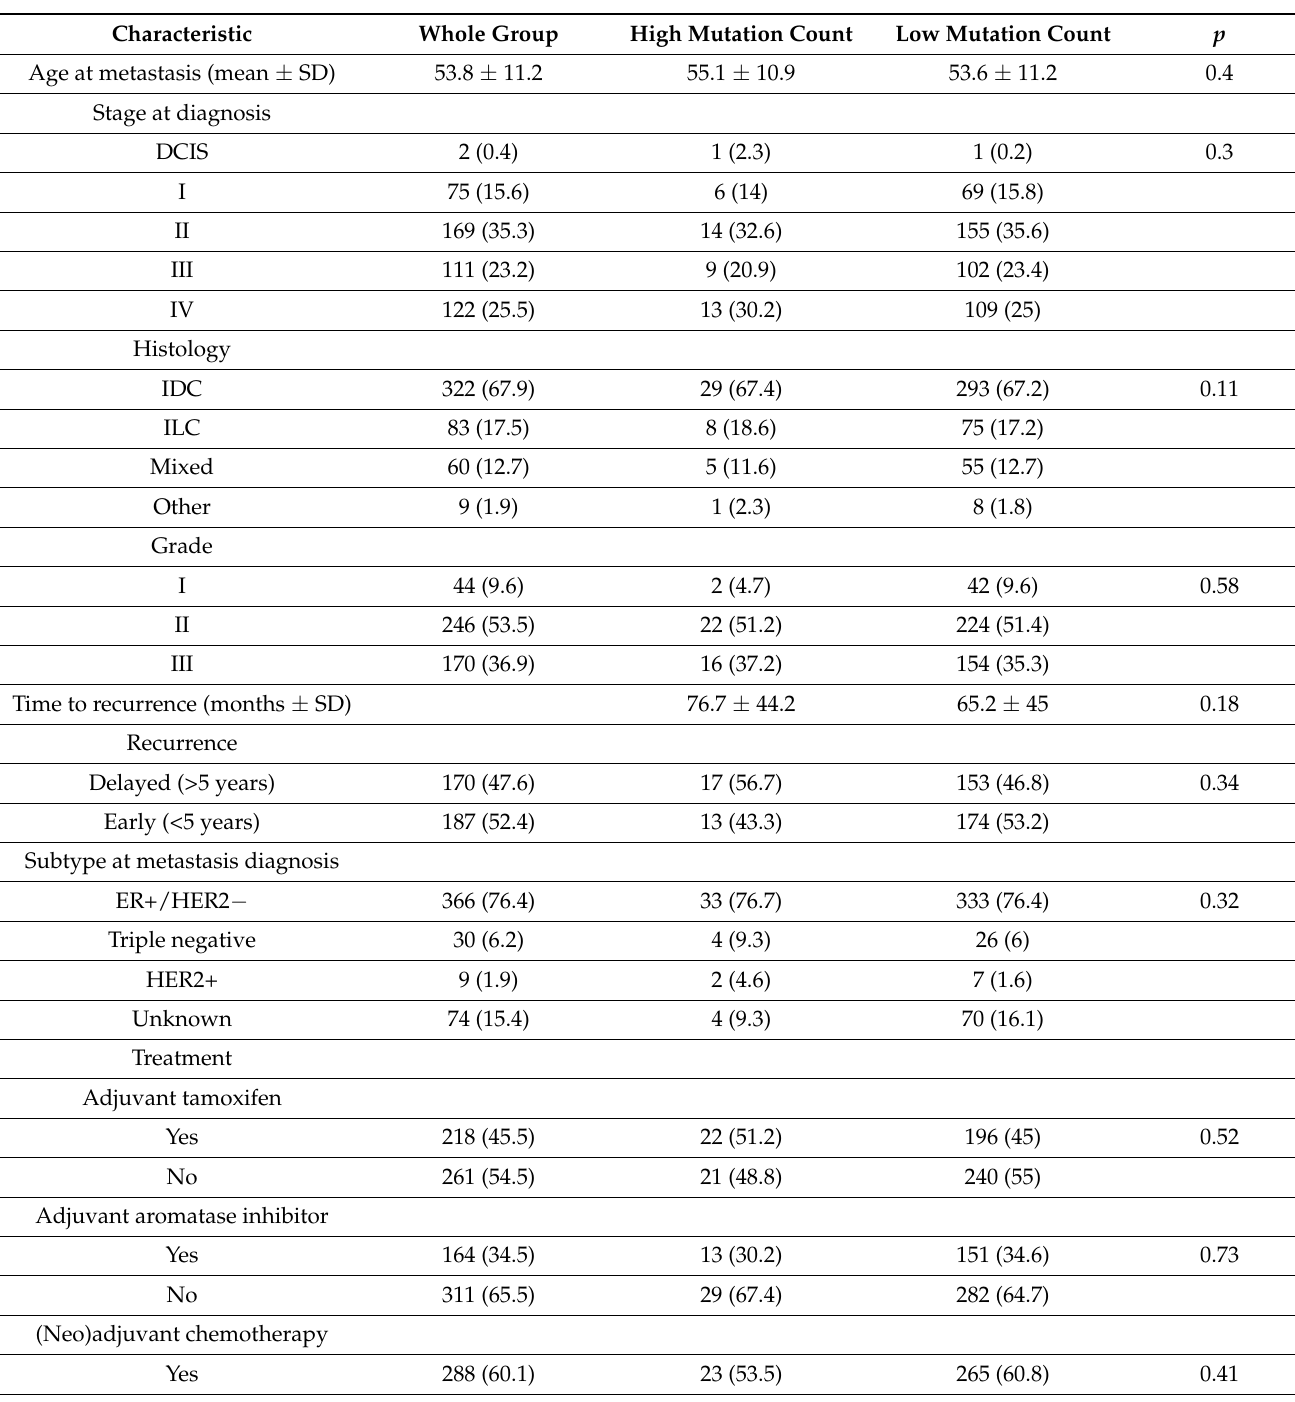
Table 6. Characteristics of the high and low mutation count groups in patients with ER-positive/ HER2-negative breast cancer patients from DFCI. DCIS—ductal carcinoma in situ; IDC—invasive ductal carcinoma; ILC—invasive lobular carcinoma. The sum of the patients in each characteristic category is variable because of missing